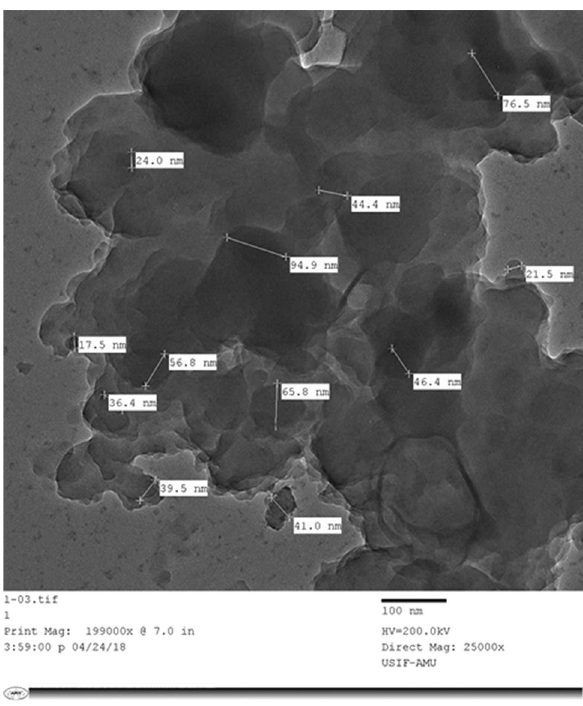
Fig. 5 TEM micrograph of RGO/PPy nanocomposite